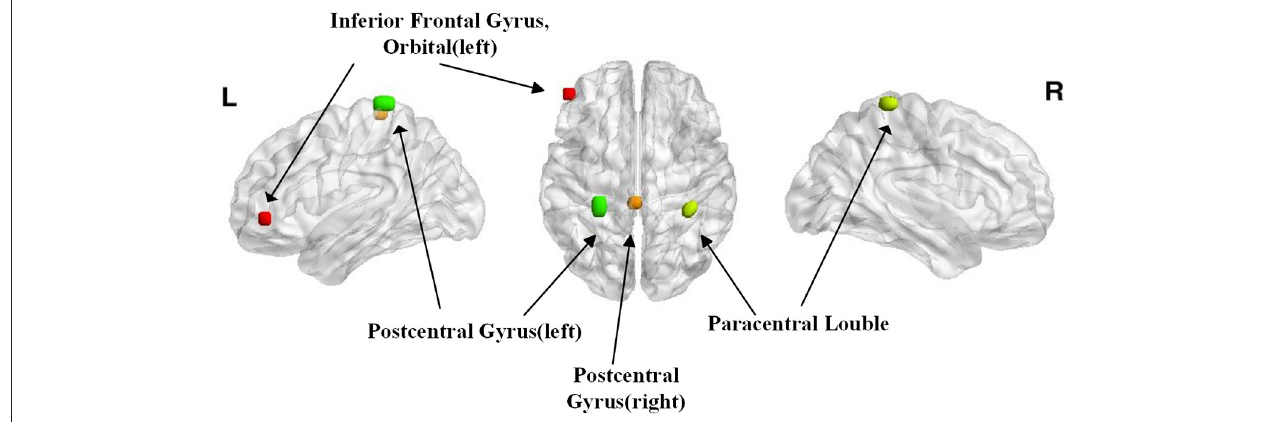
FIGURE 3 | The regions with the highest discriminative powers in the Short-time Fourier transform (STFT) + CNN